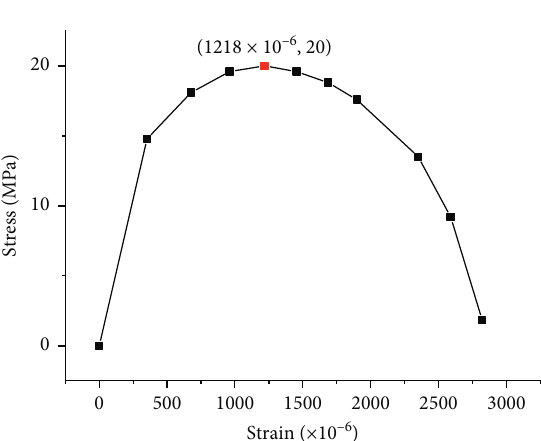
Figure 18: The compressive stress-strain of C